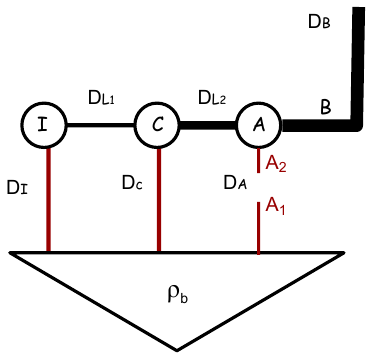
Figure 17. Illustration of the three-tensor model. The labels on each link D A , D I , etc labels the dimension of each link, which are of the value 2 n with n = j I j , j A j , etc, i.e. the number of qubit EPR pairs. In general the bulk state can be a mixed state, but we draw the pure state case for simplicity. In the super density operator, B and A 1 ; A 2 are external legs of the